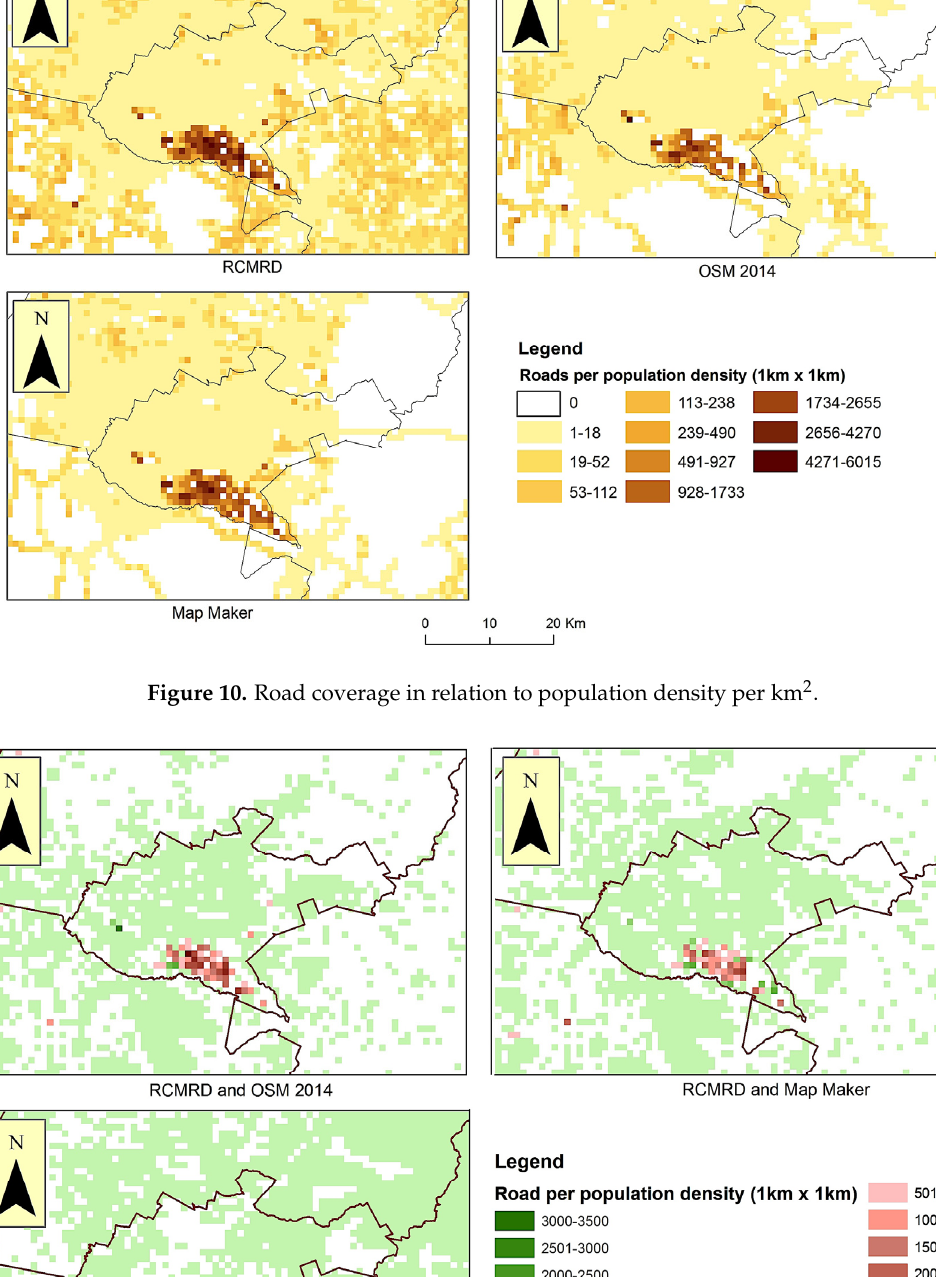
Figure 9. Population density per 1 km by 1 km in Nairobi and surrounding areas.